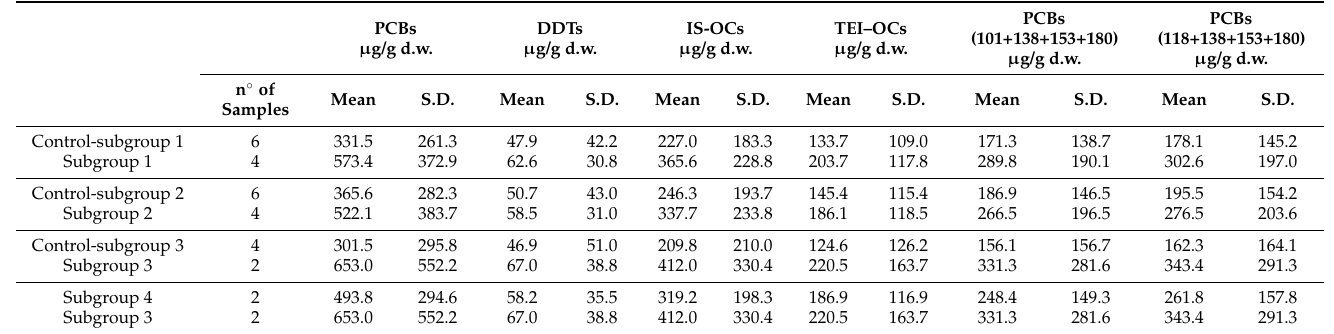
Levels of PCBs, DDTs, IS-OCs, TEI-OCs, PCBs (101+138+153+180), and PCBs (118+138+153+180) ( µ g/g d.w.) in specimens with different statuses of immunosuppression- related